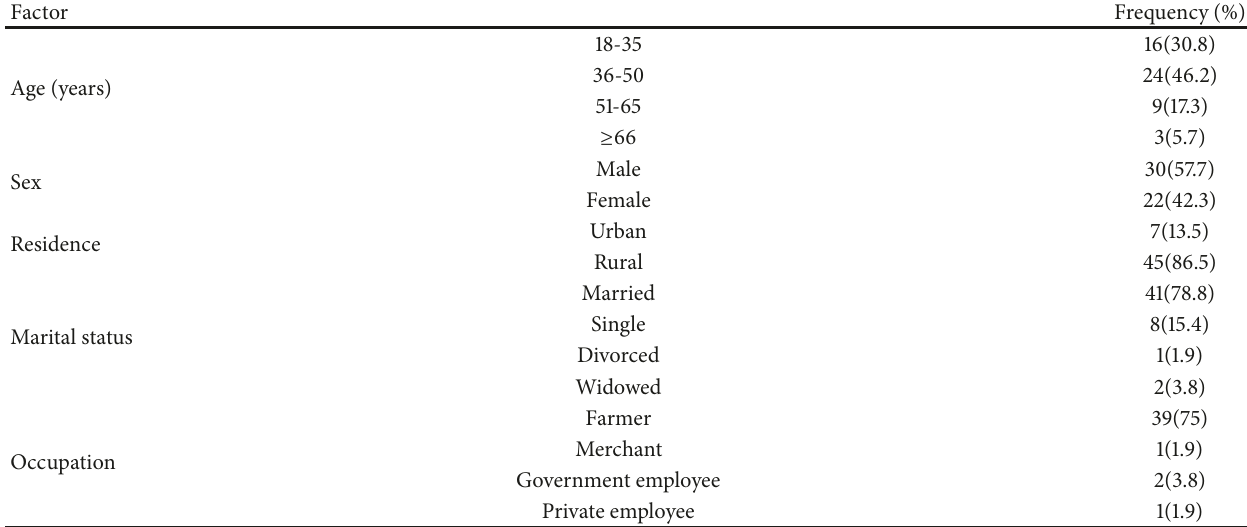
Table 1: Sociodemographic characteristics of study participants.